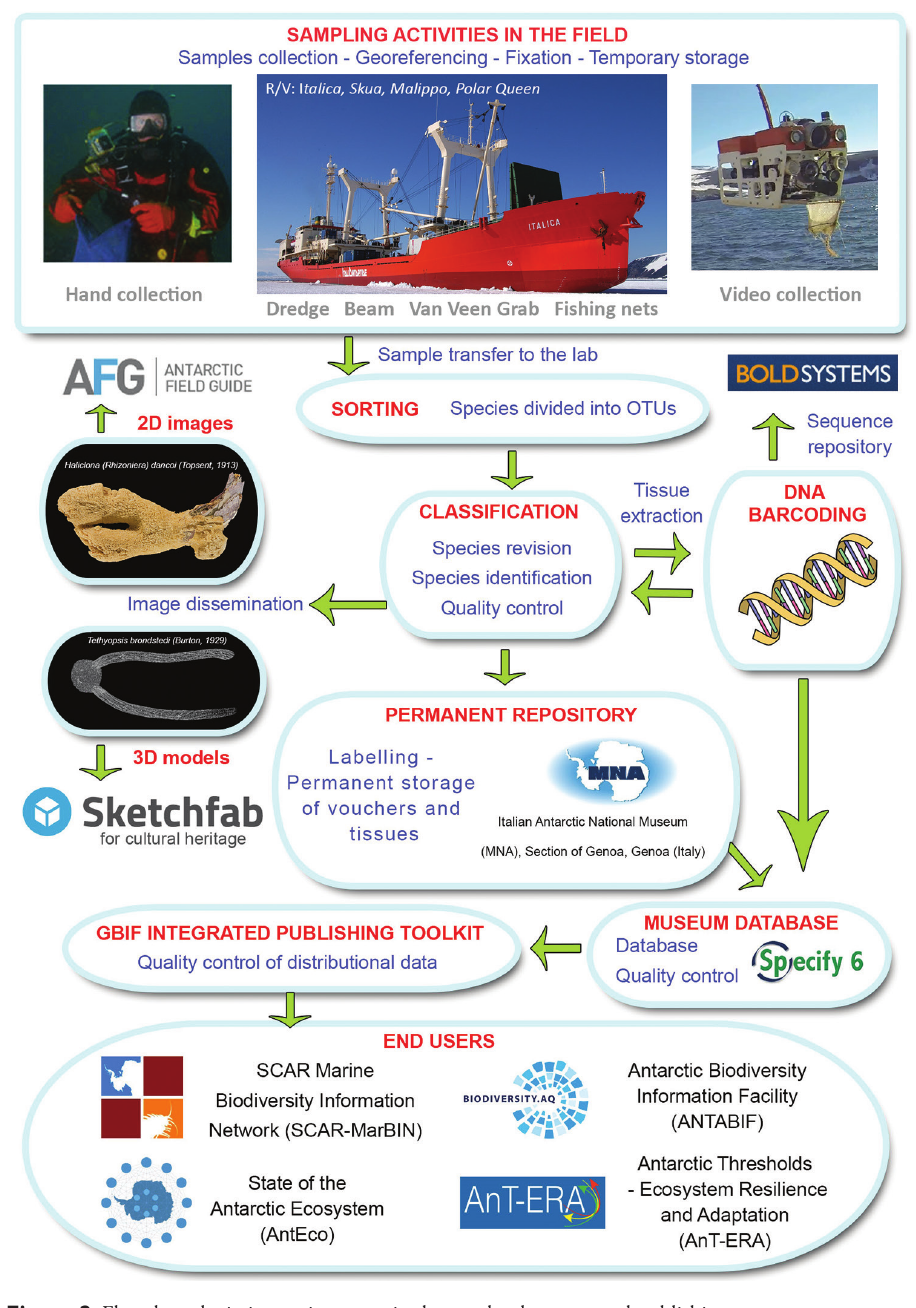
Figure 2. Flowchart depicting major stages in dataset development and